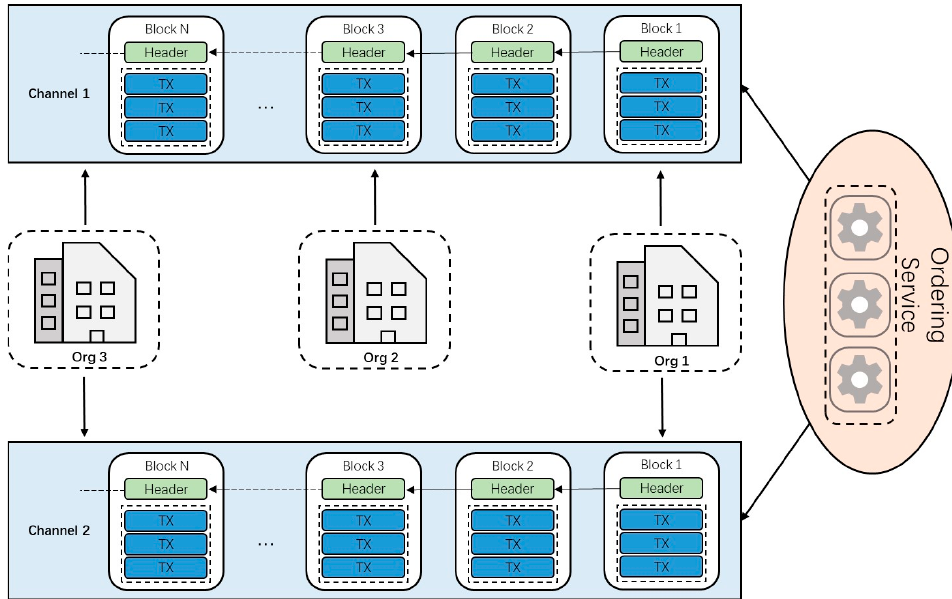
Figure 4. Demonstration of the channel-level scheme.